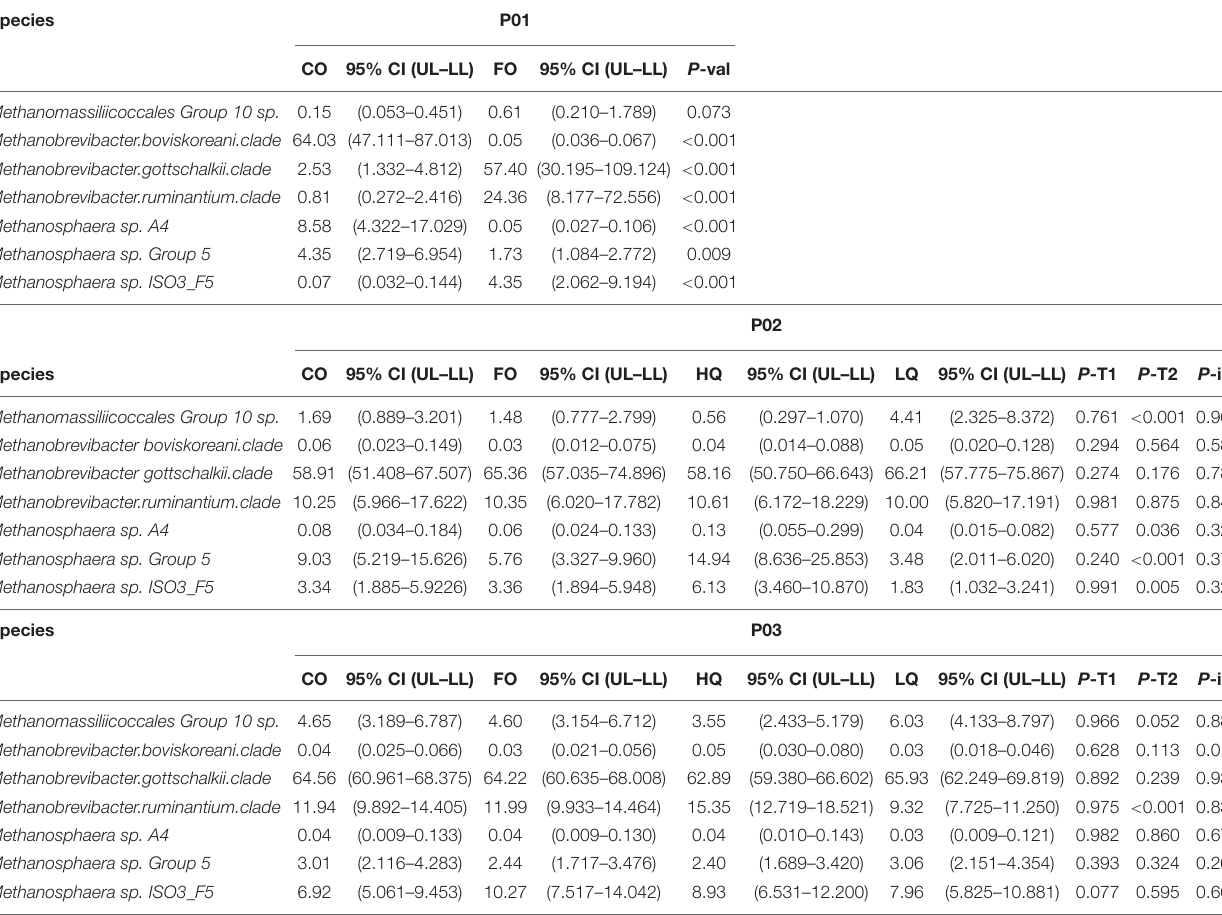
TABLE 5 | Effect of dietary treatments a on the abundant archaea species b during the three measurement phases c . Species P01